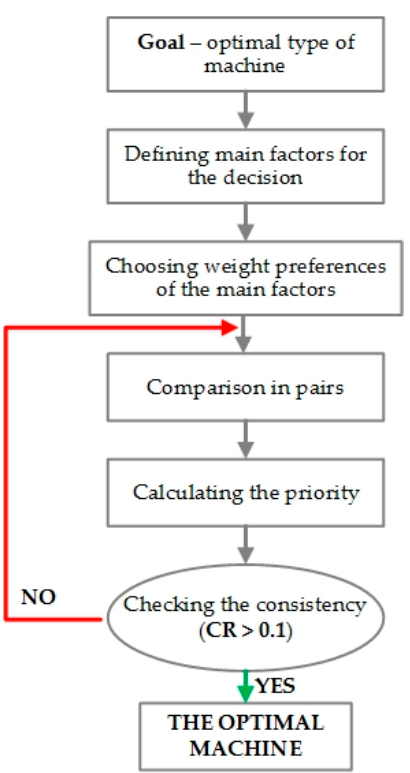
Figure 4. The stages in the decision-making process in choosing the optimal type of machine by applying the AHP method.